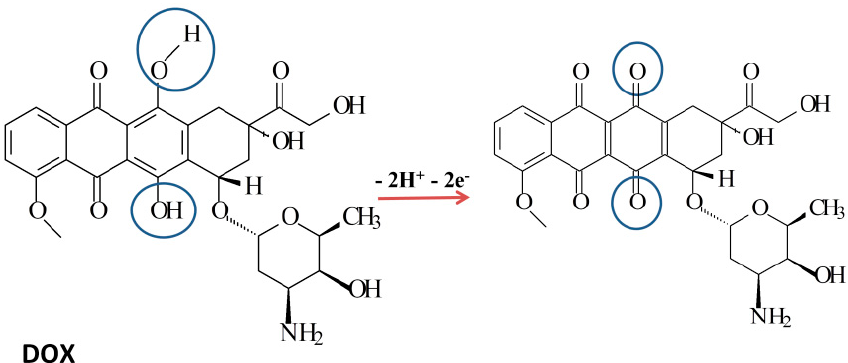
Figure 3. Proposed global mechanism for the electrochemical oxidation of DOX.